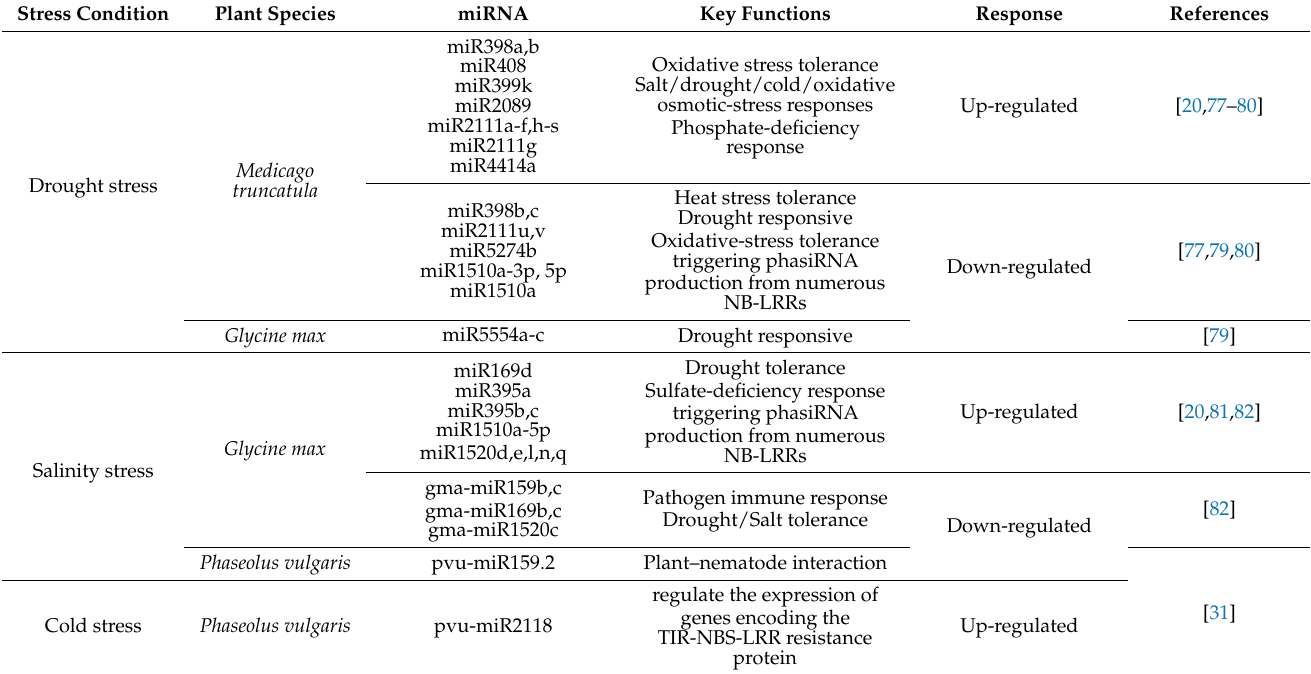
Table 3. miRNAs regulated by drought stress, salinity stress, and cold stress in